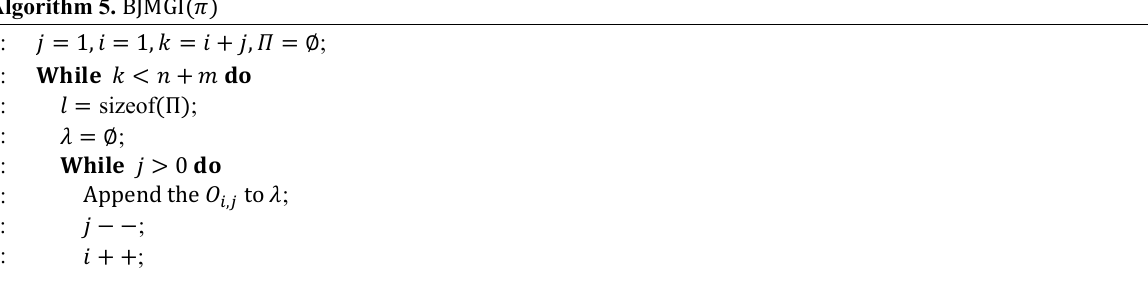
Algorithm 5. BJMGI( 𝜋